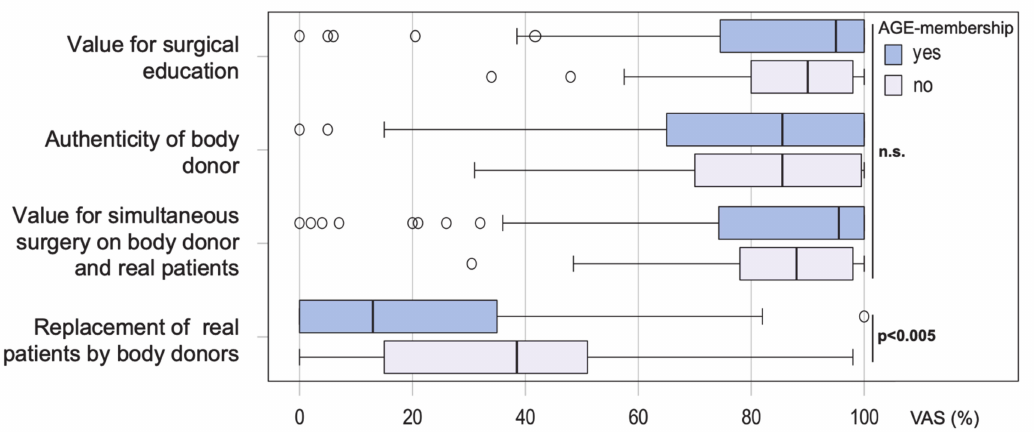
Figure 3. Value of live surgery performed on body donors: comparative subgroup analysis of AGE members and non-members. The answers were recorded on a continuous visual analog scale